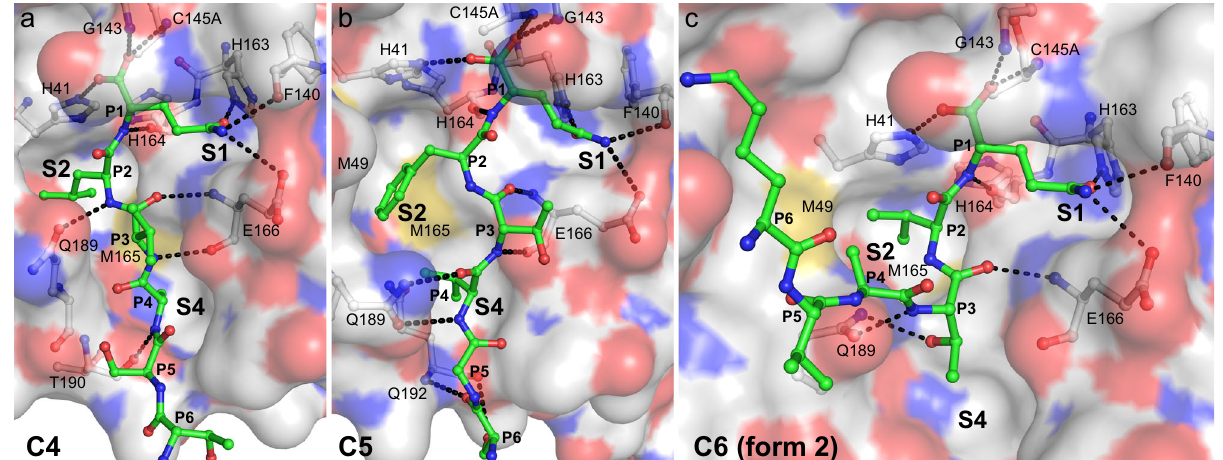
Fig.5|S2speci fi citypocketrearrangementsandhydrogenbondcomparisonof SARS-CoV-2 M pro cleavage sites C4, C5, and C6. a Cleavage site C4 with P2(Leu). b CleavagesiteC5withP2(Phe)(PDB7JOY 24 usedtomake fi gure). c CleavagesiteC6 form 2 with P2(Val). P6 – P1 are shown in ball and stick with CPK coloring (carbons